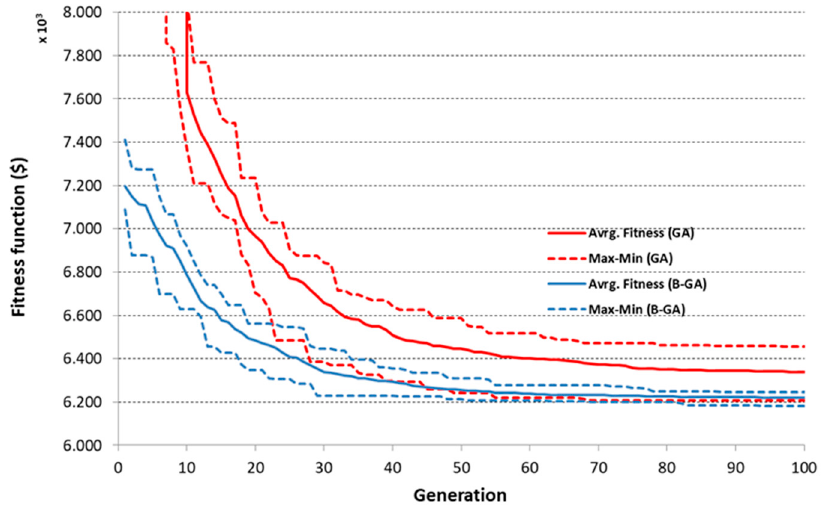
Figure 5. Evolution of the best fitness value for B-GENOME and GENOME algorithms (Hanoi Network).